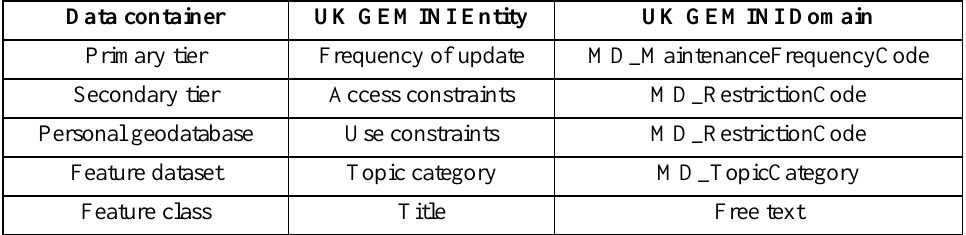
Table 2. Data container definitions based upon those UK GEMINI entities deemed appropriate for dataset categorisation. Actual container instances are labelled using the respective UK GEMINI domain values.